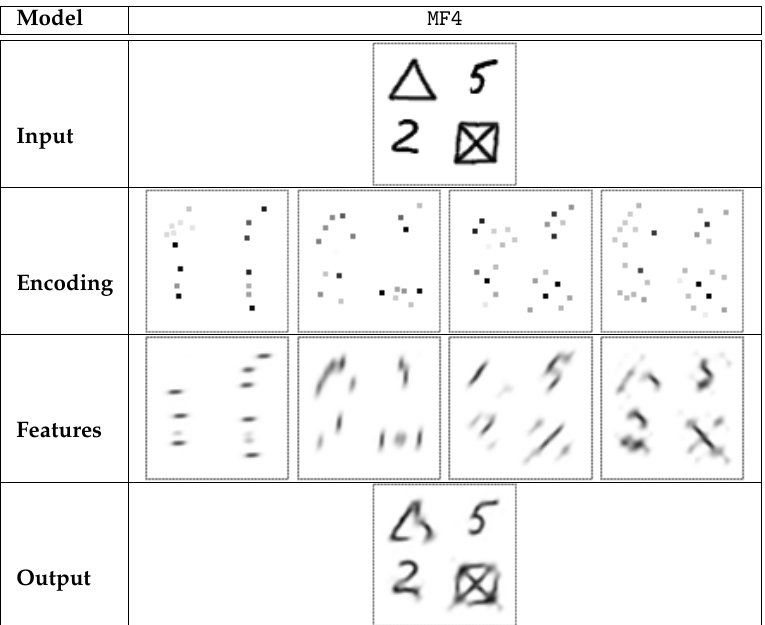
Figure 11. Sample encoding of a larger image that contains both digits and other symbols, performed with the MF4 model. The presented feature-specific decodings were generated in the same way as those presented in Figure 8.